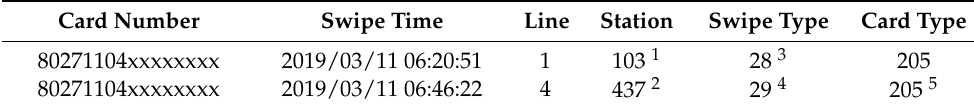
Table 1. Examples of data records of smart cards in Wuhan metro